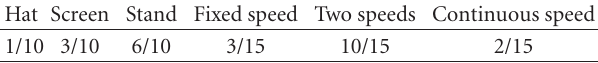
Table 3: Number of users who preferred a